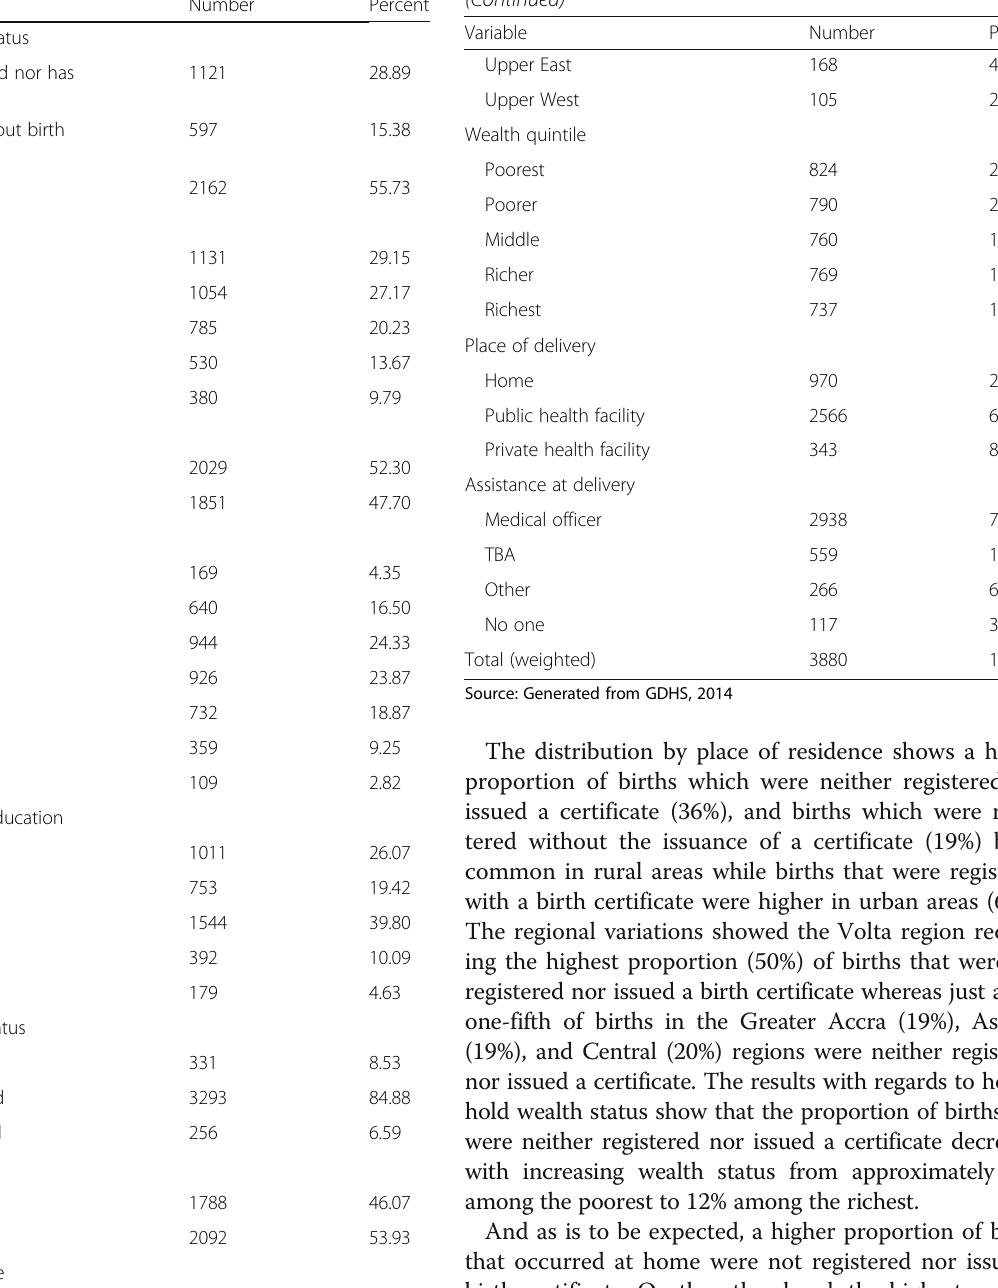
Table 1 Socio-demographic characteristics of study sample